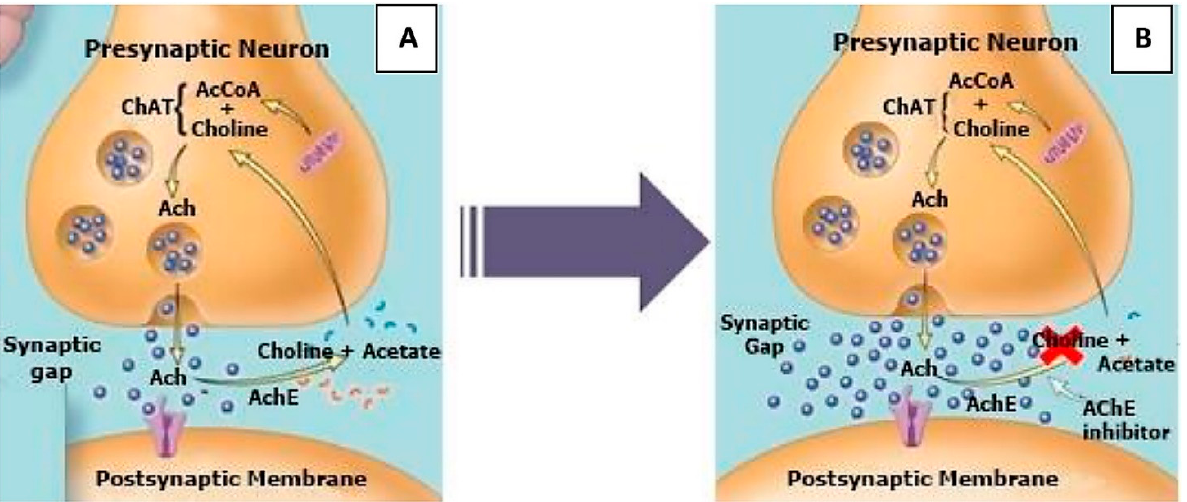
Figure 2. General scheme of the cholinergic hypothesis for AChE inhibition. ( A ) Low concentrations of acetylcholine in the synaptic gap. ( B ) Increase in concentration after inhibition of AChE. Reprinted with permission from Ref. [13]. Copyright 2020